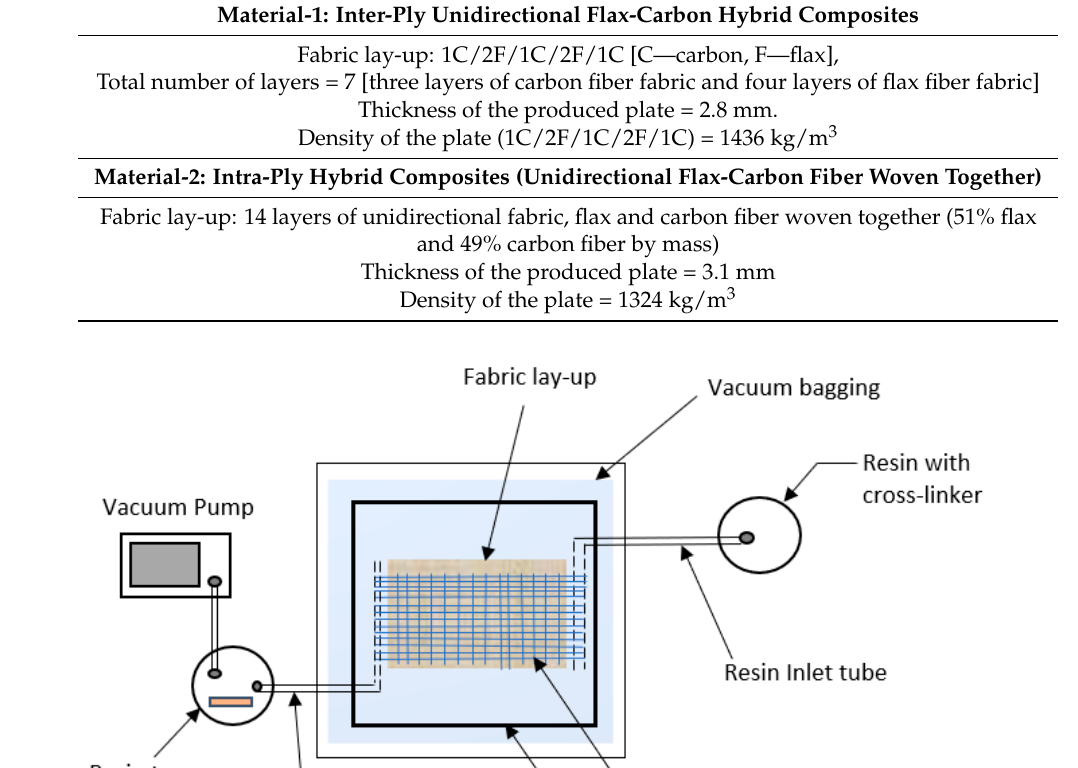
Thickness of the produced plate = 2.8 mm.